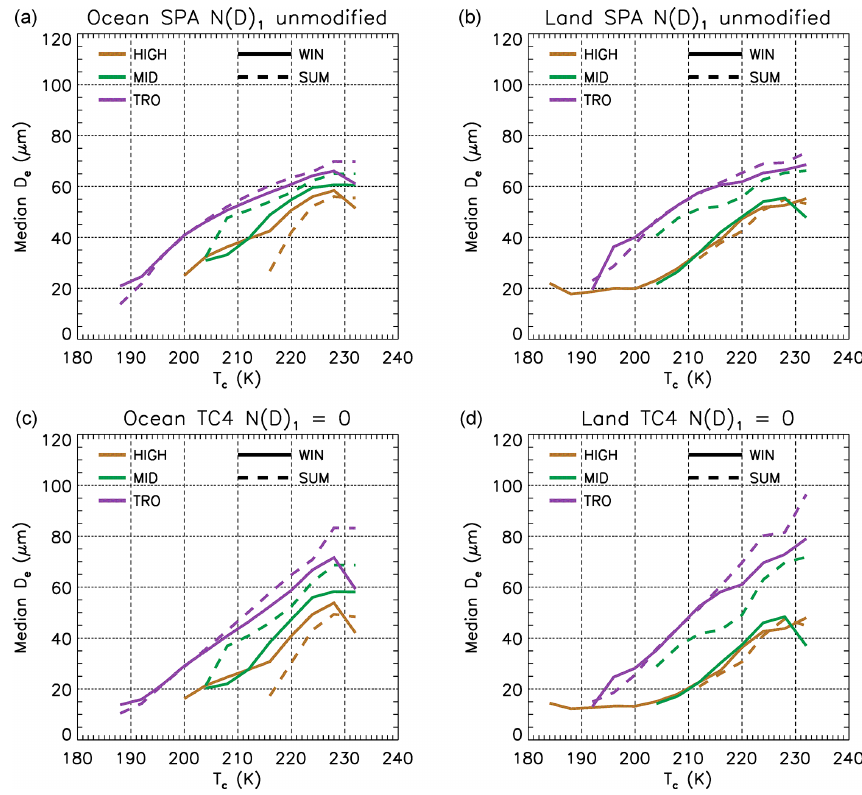
Figure 11. Temperature dependence of the retrieved median effective diameter D e (µm) in winter (solid) and summer (dashed) during 2008 and 2013, based on the SPARTICUS N(D) 1 unmodified (a, b) and the TC4 N(D) 1 = 0 (c, d) formulations. Latitude zones are denoted by colors: purple: 0–30 ◦ (TRO); green: 30–60 ◦ (MID); and brown: 60–82 ◦